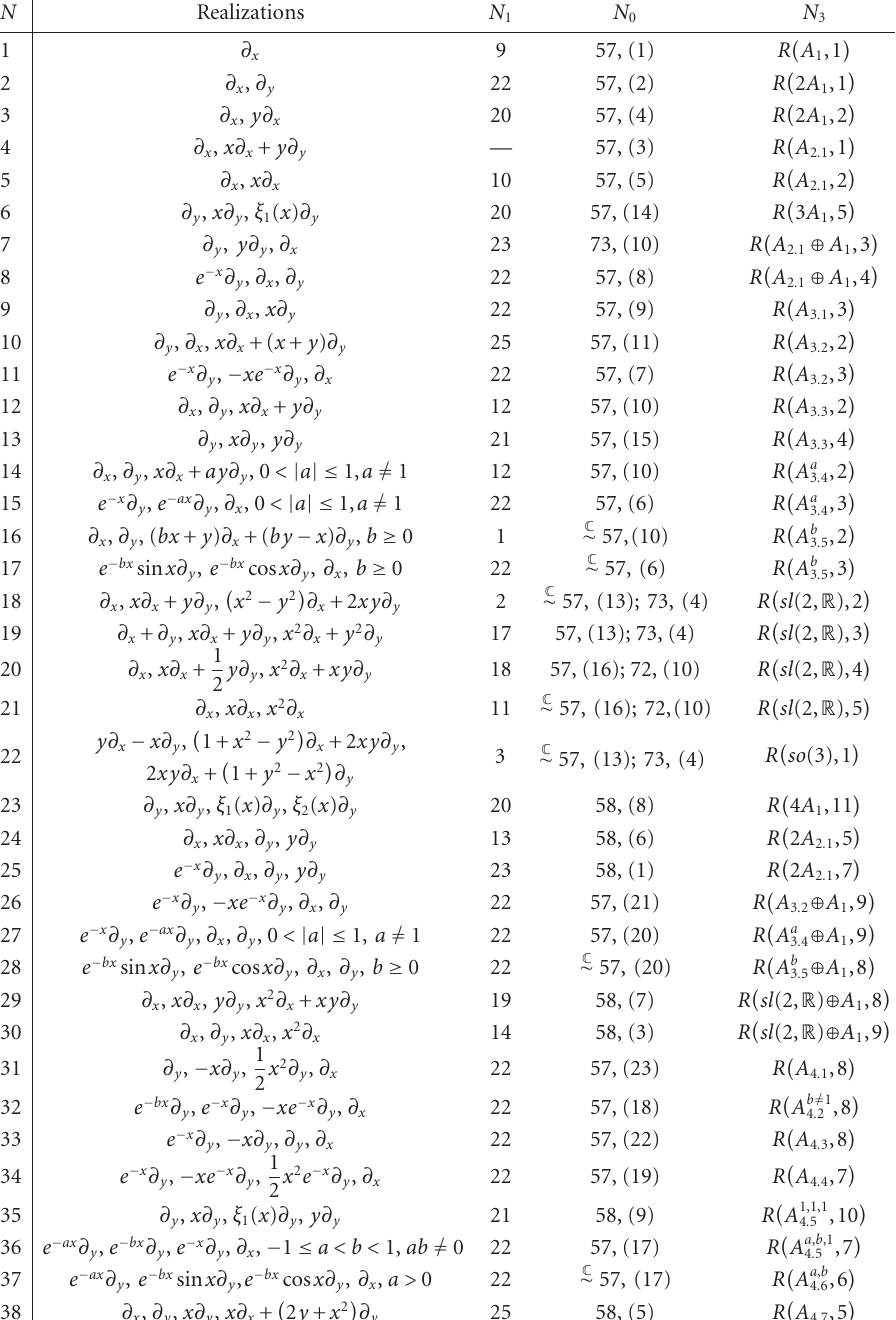
Table 1.1. Realizations of Lie algebras on the real